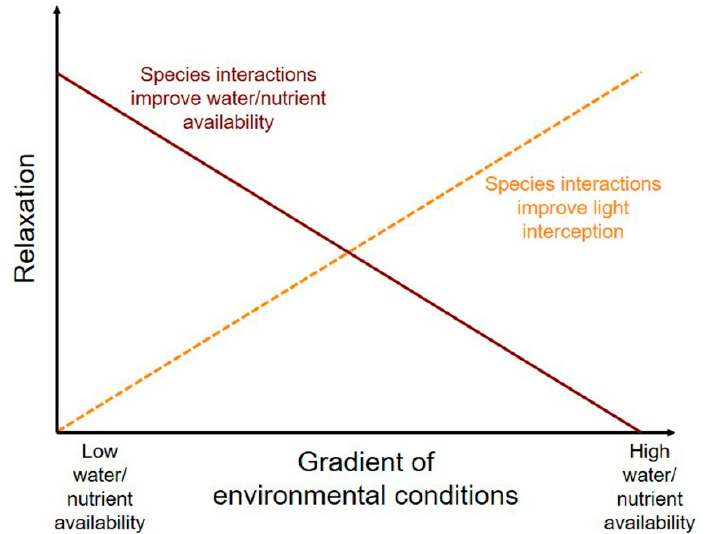
Figure 5. Conceptual framework for variation of mixing effects along spatial or temporal gradients of resource availability (based on [142] and [128]). If species’ interactions enhance relaxation (sensu [129]) regarding water or nutrients, positive biodiversity effects will increase along decreasing gradients of water or nutrients availability (solid dark red line). On the contrary, light-related interactions will result in increased forest productivity as site quality and climate improve (dashed orange line).